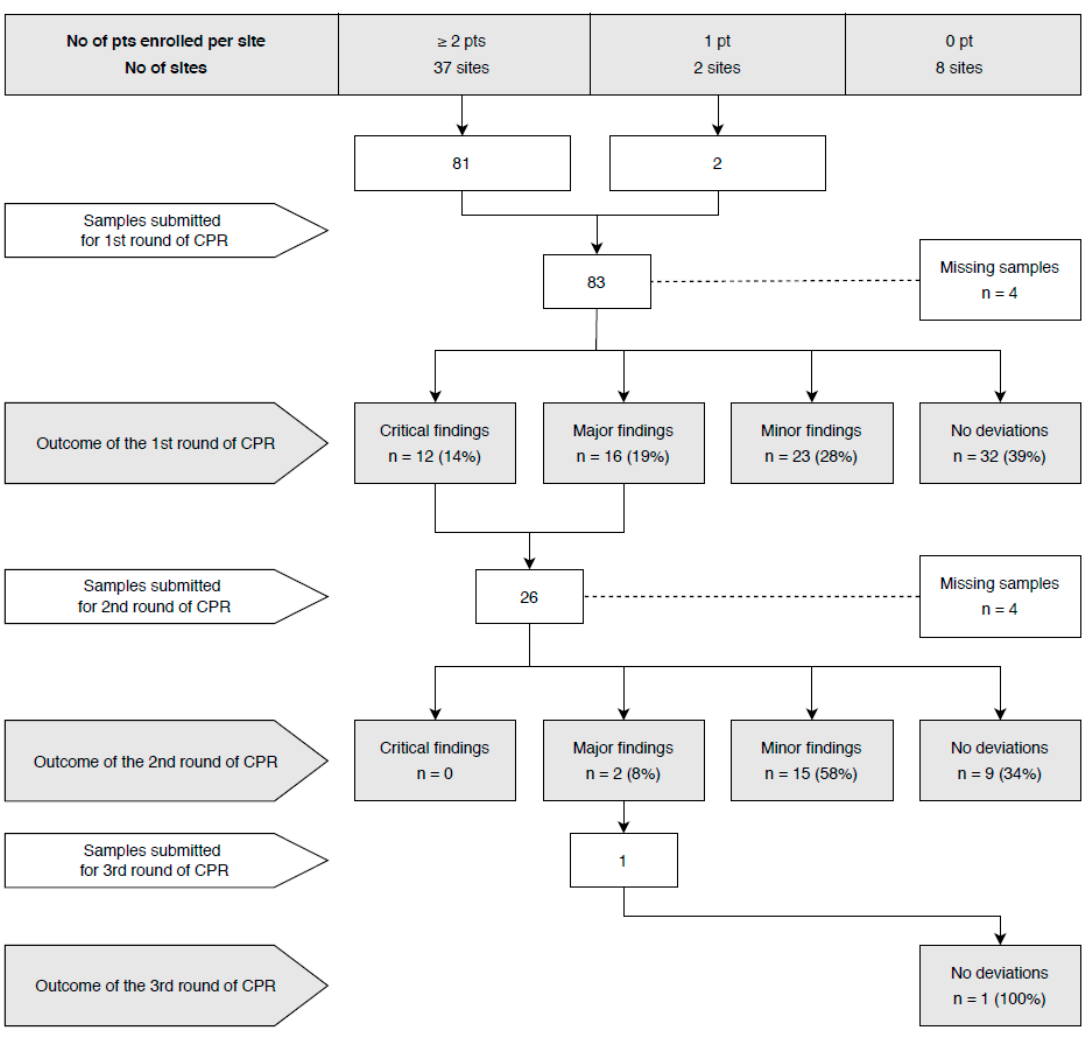
Figure 1. Flow chart of the central pathology review (CPR).